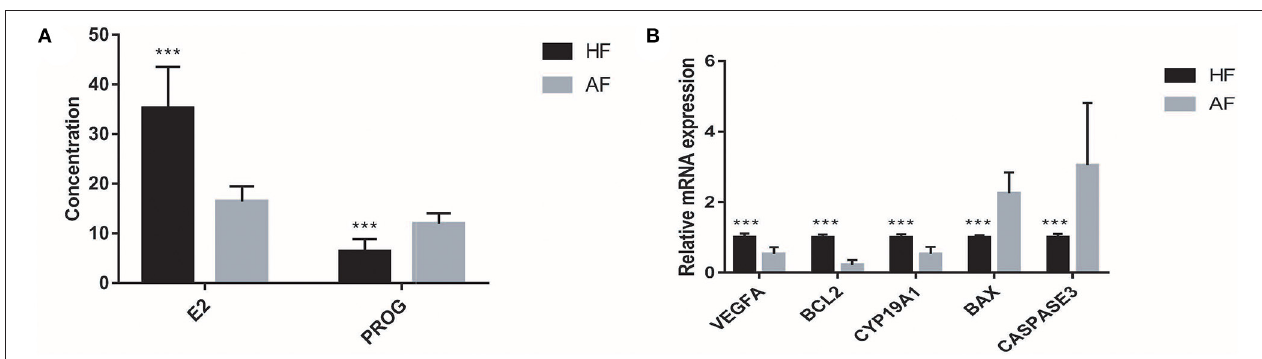
FIGURE 2 | The hormone contents and gene expressions in the healthy follicle (HF) and atretic follicle (AF) samples. (A) The contents of estradiol (E2) and progesterone (PROG) in the follicular fluid (FF) from HF and AF, respectively. (B) The relative mRNA expressions of VEGFA , BCL2 , CYP19A1 , BAX , and CASPASE3 genes in the HF and AF samples, respectively. *** highly significant difference between the two groups ( p < 0.01).